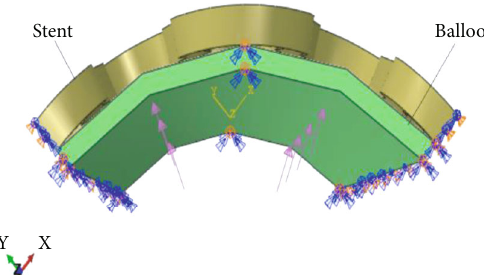
Figure 6: FE model with loading and boundary